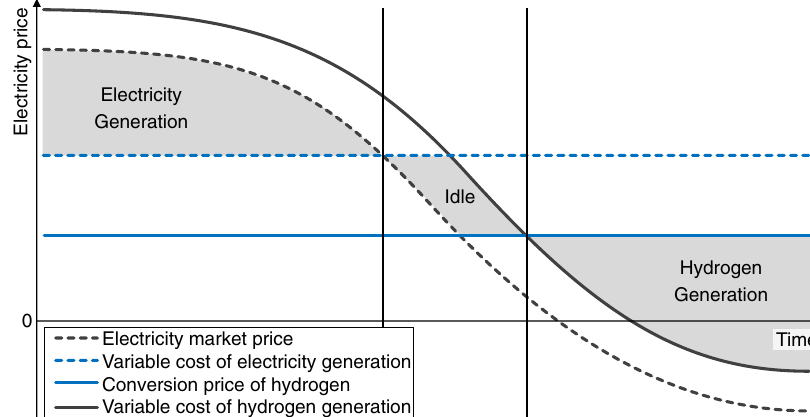
Fig. 1 Contribution margins of a reversible Power-to-Gas system. The fi gure illustrates the three alternative operating modes for either a modular or an integrated reversible PtG system that emerge for varying electricity prices. Wholesale electricity prices can turn negative as a result of surplus energy being supplied to the grid at certain